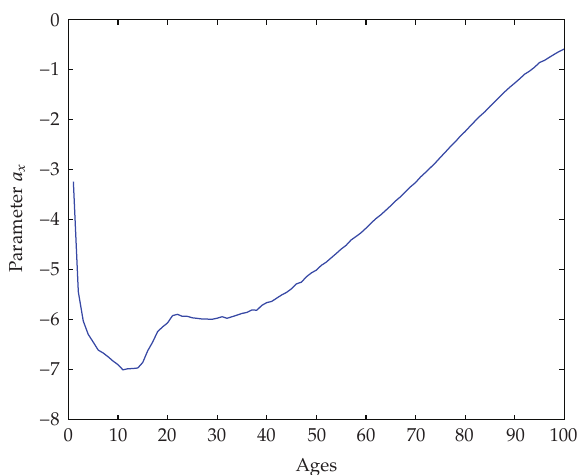
Figure 1: Parameter (cid:8) a x based on the Swedish male 1921–1960 mortality